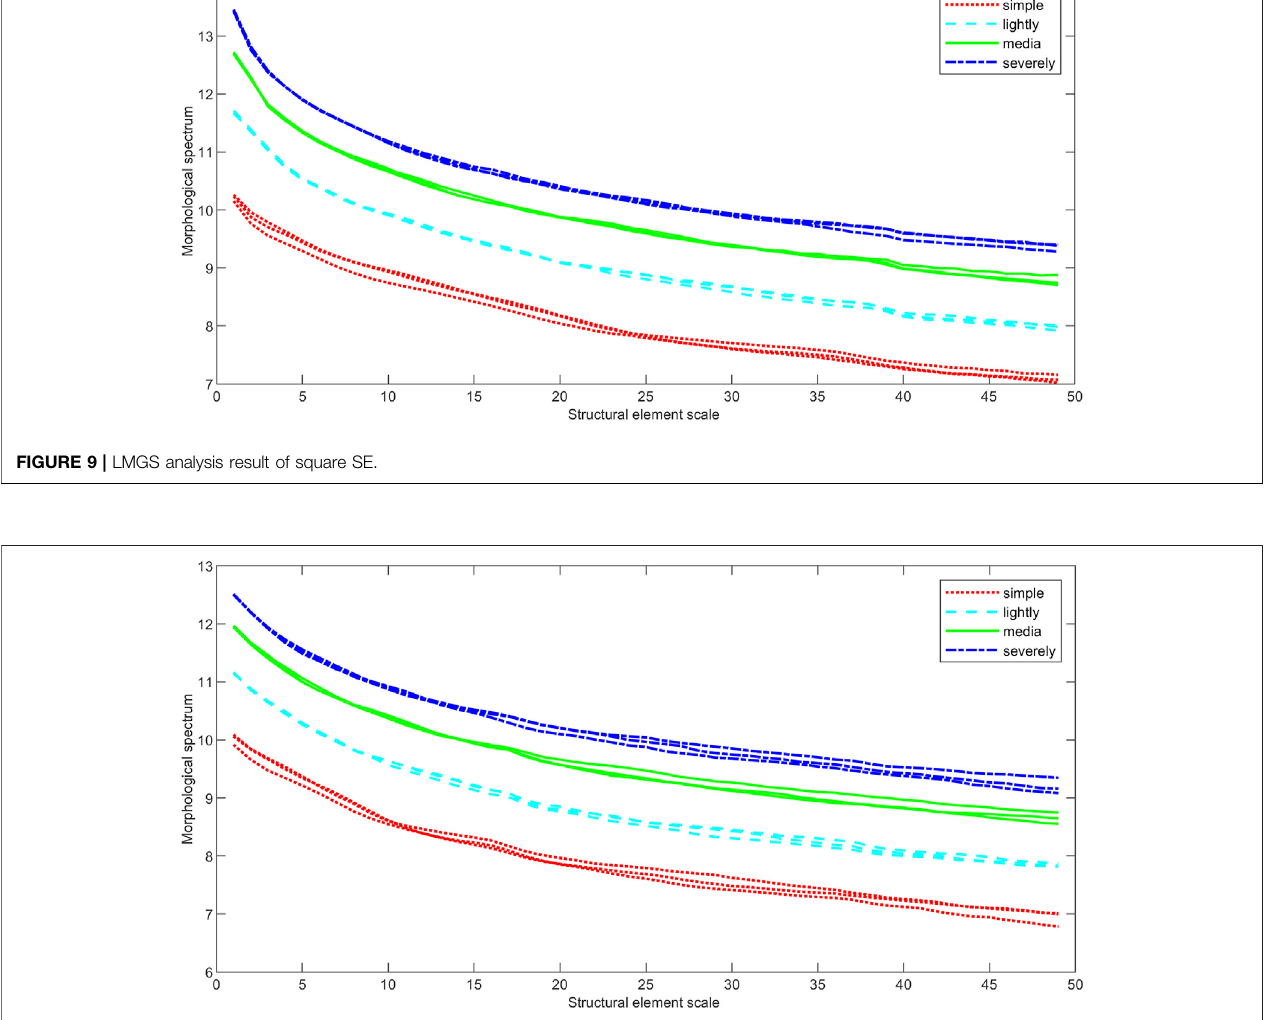
FIGURE 10 | LMGS analysis result of diamond SE.